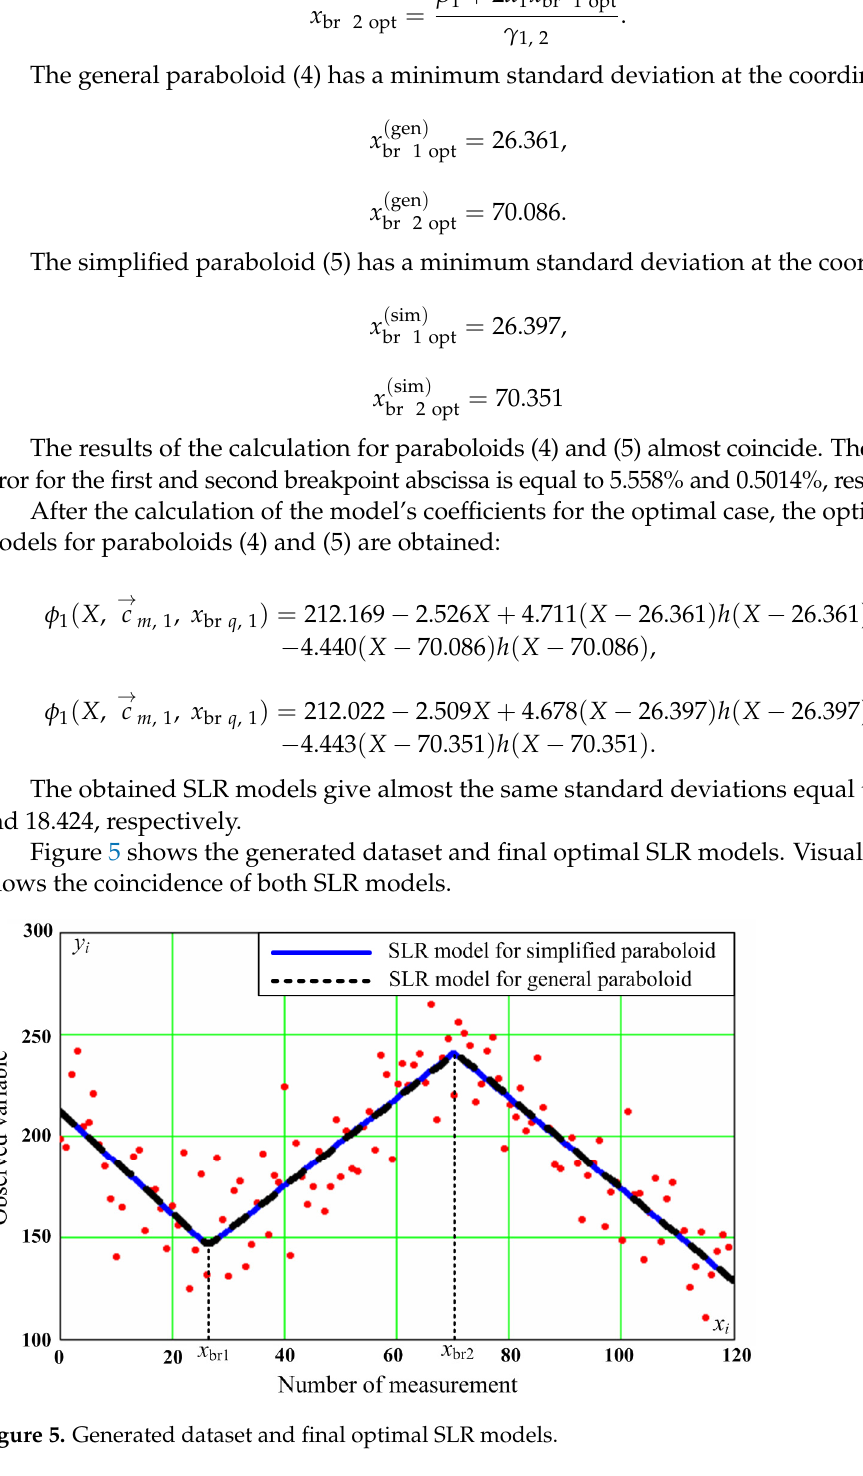
Figure 6. Histograms for breakpoint abscissas for different optimization options: ( A )—estimates of the first breakpoint for general paraboloid; ( B )—estimates of the second breakpoint for general paraboloid; ( C )—estimates of the first breakpoint for simplified paraboloid; ( D )—estimates of the second breakpoint for simplified paraboloid.